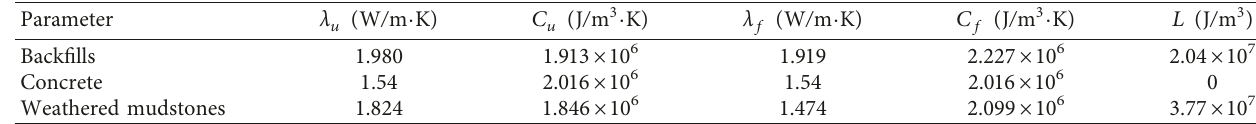
Table 2: Thermal parameters